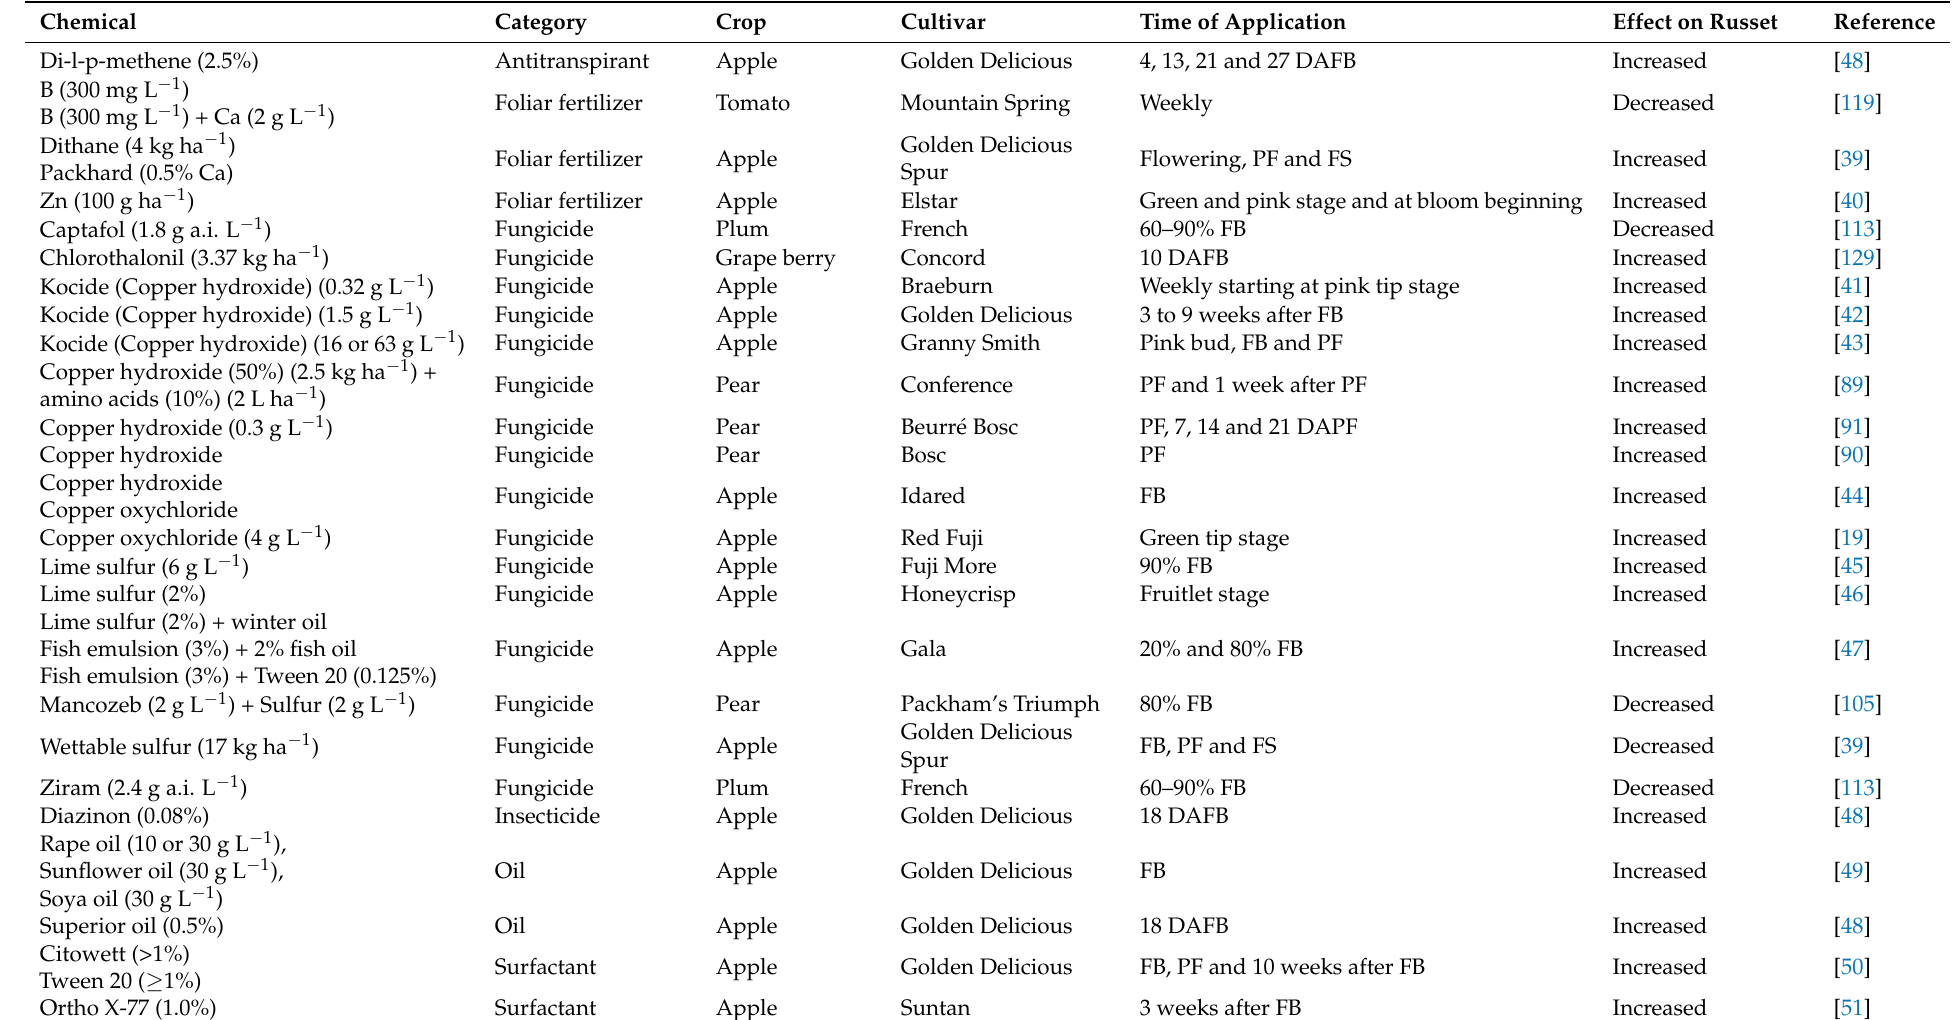
Table 3. Effect of fungicides, surfactants and foliar fertilizers on russet. Results are compiled from literature